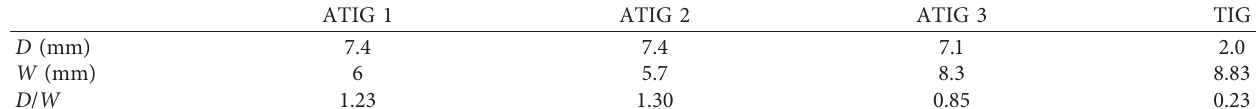
Table 9: Morphology of TIG and ATIG welds.